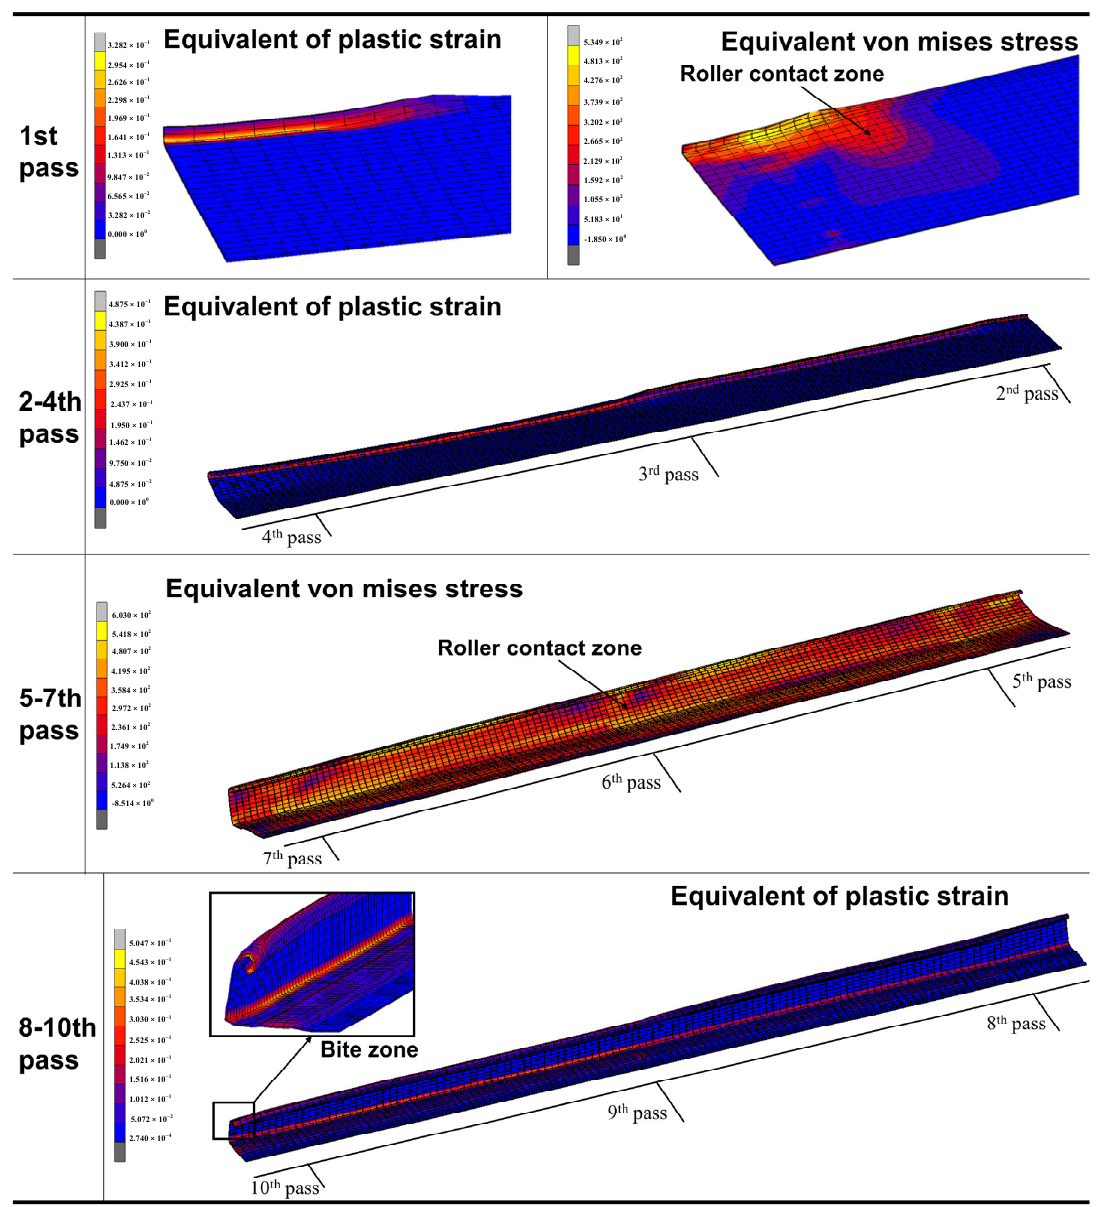
Figure 7. The forming quality of the bite segment.